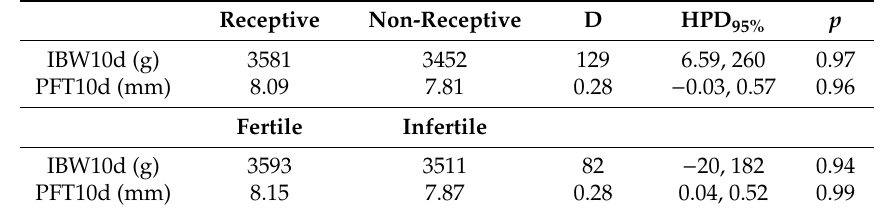
5 of 9 Figure 1. Development of individual body weight and perirenal fat thickness at second mating, delivery, 10 days after delivery and weaning in the low and high lines. The bars show standard deviation. 3.2. Effect of Body Condition on Receptivity and Fertility Table 2 shows that receptive females had higher individual body weight and perirenal fat thickness than unreceptive females (+129 g, p = 0.97 for body weight; +0.28 mm, p = 0.96 for perirenal fat thickness). Individual body weight and perirenal fat thickness were higher in fertile females